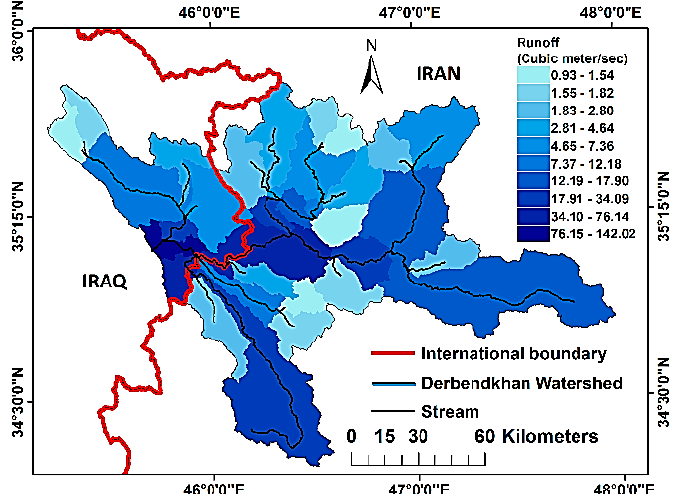
Figure 16. Average streamflow for the Derbendkhan Watershed at the sub-basin level for the period from 1984 to 2013.